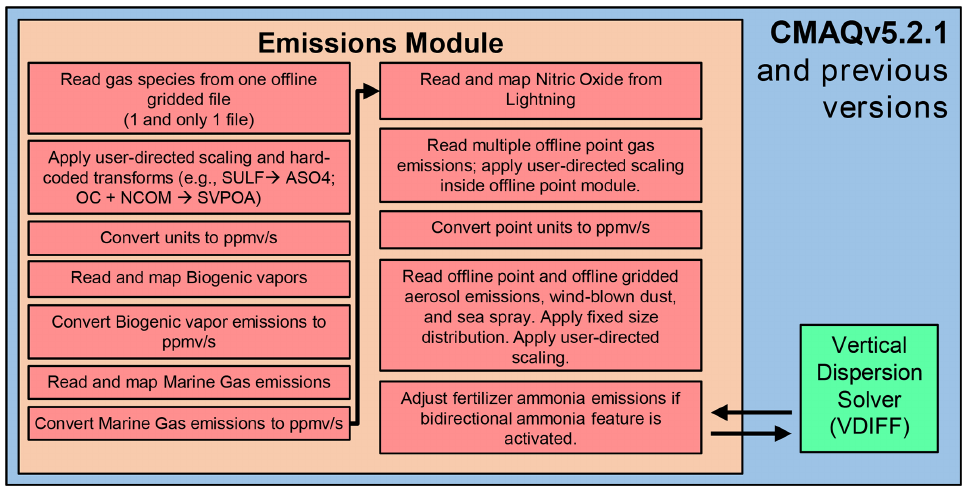
Figure 2. Algorithm for emission processing used by CMAQv5.2.1 and previous